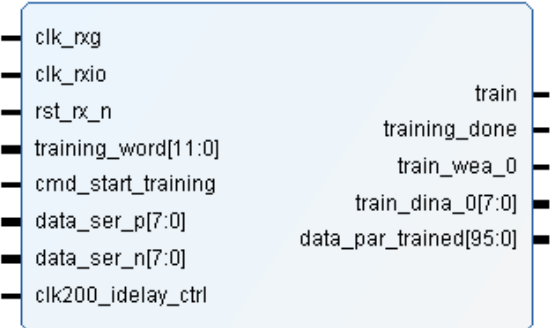
Figure 5. Module interface of training.v.